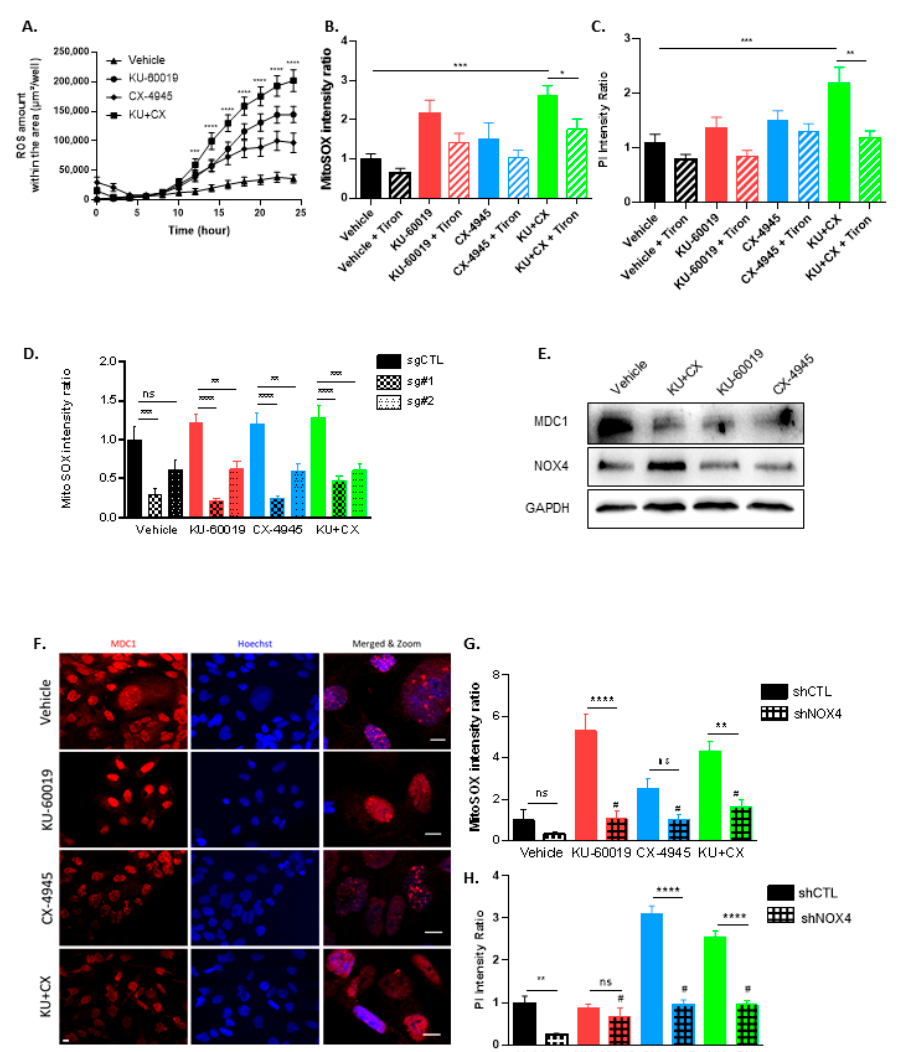
Figure 5. ROS-mediated apoptosis induced by CK2 and ATM co-inhibition. ( A – C , E ) MCTS of 786-O VHL − cells treated with Vehicle (DMSO, 0.1%), KU-60019 (10 µ M) and/or CX-4945 (5 µ M) ± Tiron (400 µ M) for 24 h ( A , B ) or 48 h ( C ). ( D ) MCTS of 786-O HIF-2 α CRISPR/CAS9 (Sg#1 and Sg#2) and 786-O CTL CRISPR/CAS9 (sgCTL) were treated either with vehicle (DMSO) or KU-60019 (10 µ M) and/or CX-4945 (5 µ M) for 48 h. ( F ) Fluorescence images of 786-O VHL − cells stained with MDC1 and Hoechst after a 48 h treatment with DMSO (control, 0.1%), KU (5 µ M) and/or CX (2.5 µ M), scale bar = 20 µ m. ( G , H ) MCTS of 786-O VHL − shNOX4D and 786-O VHL − shCTL cells treated with Vehicle (DMSO, 0.1%), KU (10 µ M) and/or CX (5 µ M) for 24 h ( G ) or 48 h ( H ). ( A , B , D , G ) ROS production (O2 • − ) was assessed over 24 h using the MitoSOX fluorescent reagent (5 µ M) in real-time using the IncucyteZOOM Imager. ROS production under treatments is represented over 24 h in ( A ) ( n = 36), while ( B ) ( n = 12), ( D ) ( n = 9) and ( G ) ( n = 12) represent the ROS production at 18 h. ( C , H ) MCTS were treated simultaneously with PI (0.5 µ g/mL) and drugs. Cell mortality (PI incorporation) was assessed over 48 h using IncucyteZOOM. PI incorporation under treatments is represented at 32 h ( C , n = 24) and 48 h ( H , n = 24). ( E ) 786-O VHL − MTS Western blot analysis showing protein expression levels of MDC1, NOX4 and GAPDH as loading control. Two-way ANOVA and one-way ANOVA were used for kinetics and plots, respectively. * p < 0.05, ** p < 0.01, *** p < 0.001, **** p < 0.0001, ns: not significant, #: not significant compare to Vehicle-shCTL. Mechanistically, these results suggest that the combined inhibition of CK2 and ATM in renal cancer cells triggers an HIF-2 α /NOX4-dependent ROS overproduction, leading to cellular damages and ultimately to Caspase-mediated irreversible cell death (Figure